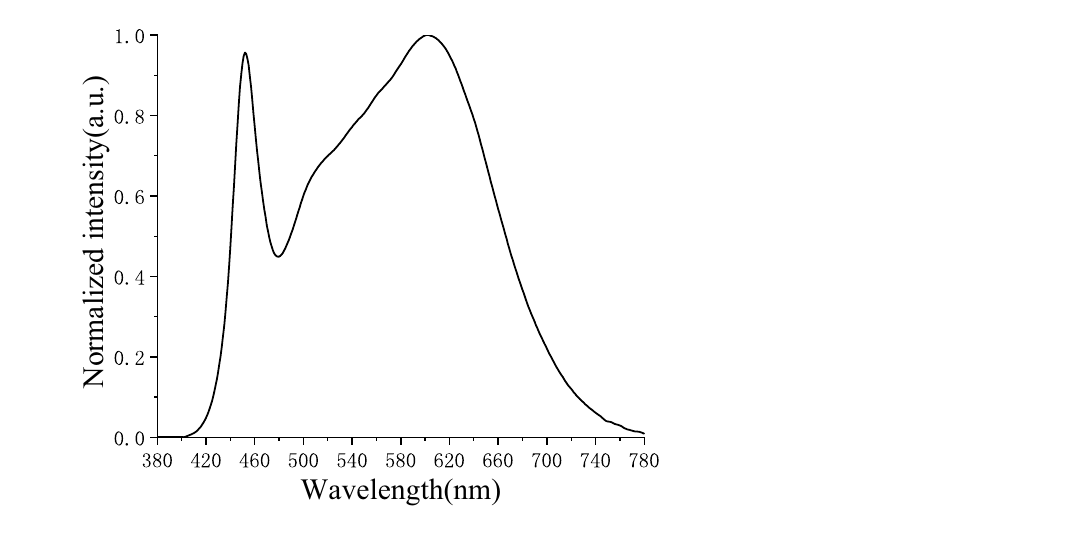
Figure 5. Relative SPD of experimental LED(4000